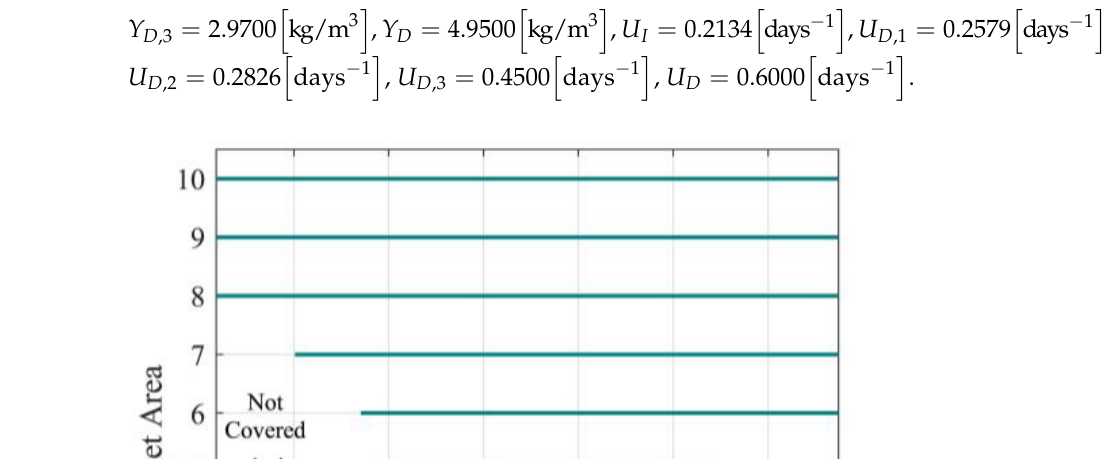
( b ) Figure 5. ( a ) Substrate concentration response and estimation for single step transition; ( b ) Micro- organism concentration response and estimation for single step transition. Figure 6. Target operating areas.